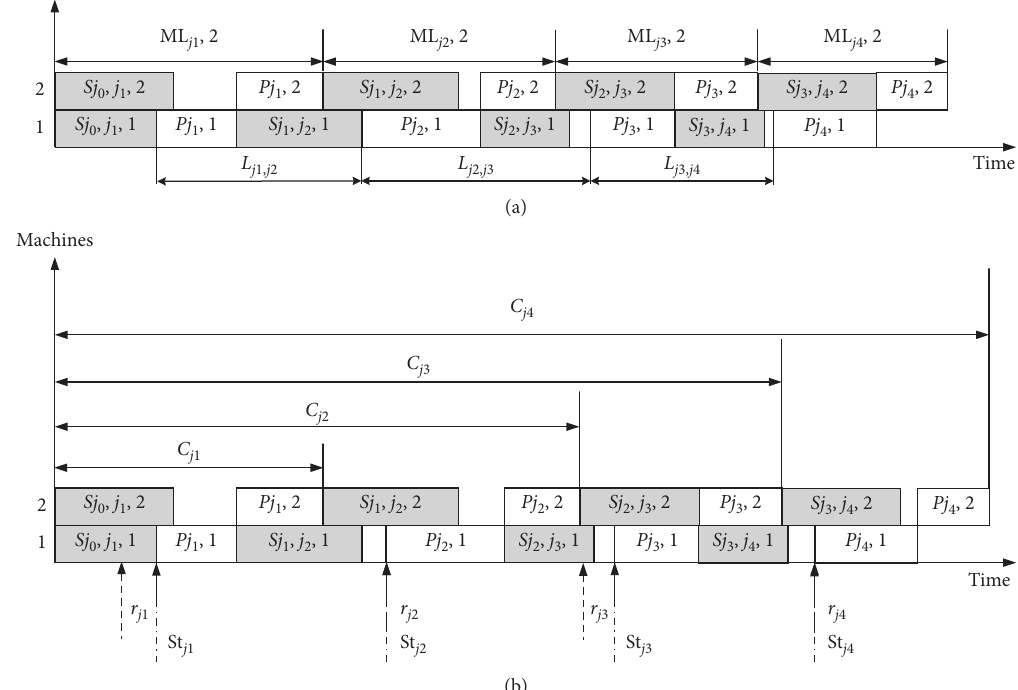
Figure 1: Two examples when n � 4 and m � 2. (a) NFSSP with SDSTs when n � 4 and m � 2. (b) NFSSP with SDSTs and RDs when n � 4 and m �